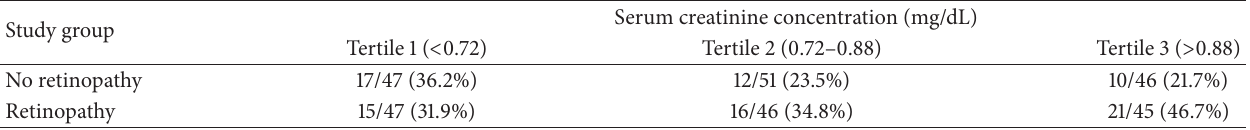
Table 3: Frequency of vitamin D deficiency, defined as 25(OH)D < 15ng/mL, according to tertiles of serum creatinine concentrations in the 2 study groups.